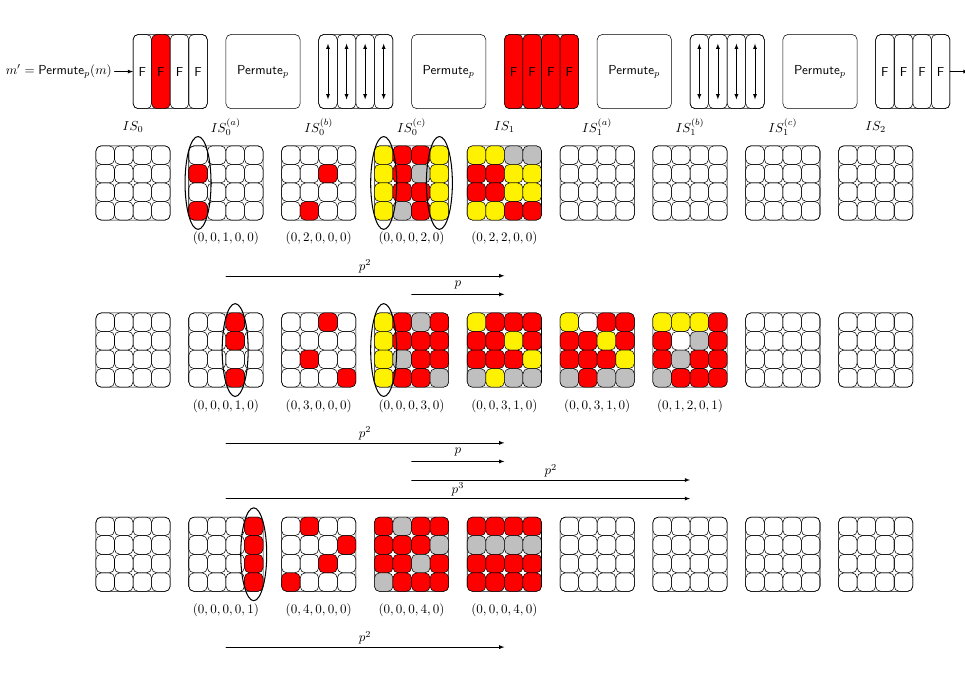
Figure 7: Differential trails of the form (1 → 4 → 1) in SE K , 3 , where Permute p is instantiated by the original cell permutation of Midori